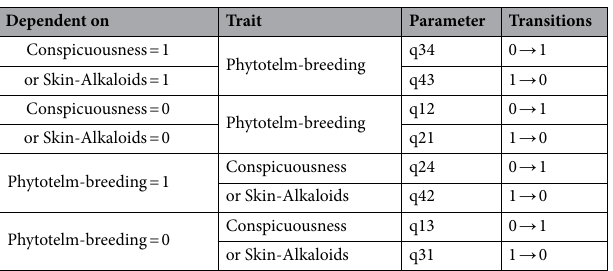
Table 5. Parameters of the dependent models using aposematism components (conspicuousness or skin- alkaloids) versus phytotelm-breeding